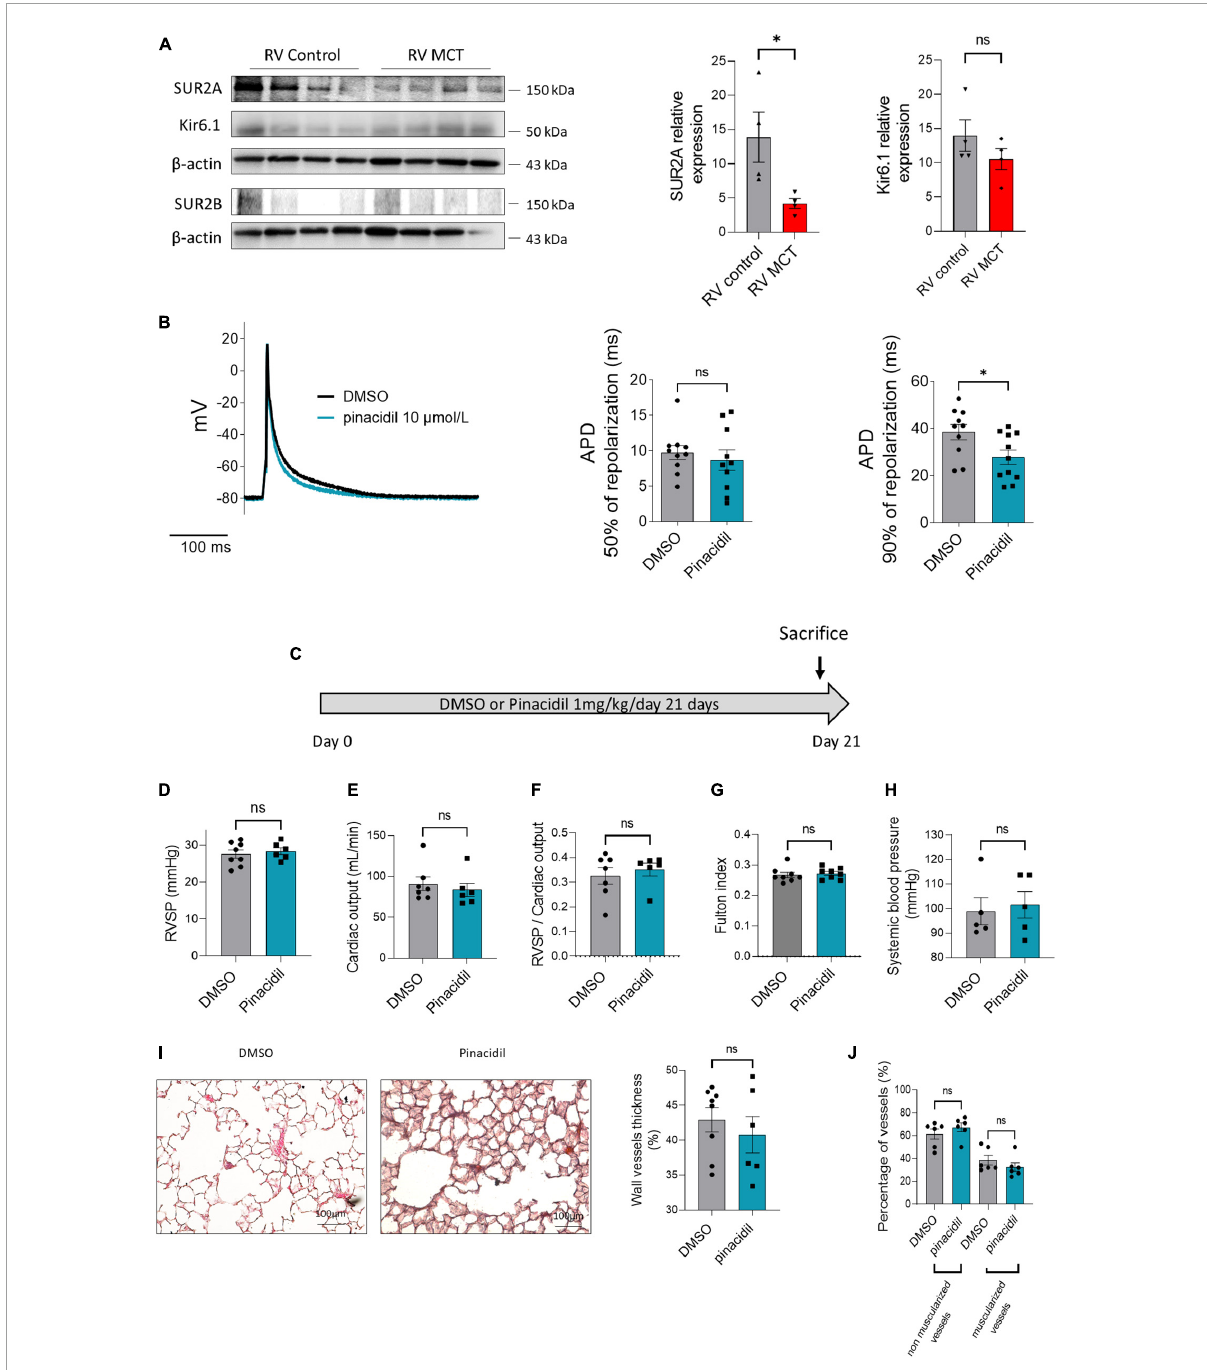
FIGURE5 Consequences of SUR2 pharmacological activation in the RV compartment ( in vitro and in vivo ). (A) Representative Western blots of SUR2A, SUR2B1, and Kir6.1 in RV from control and MCT-PH rats (3 weeks), and quantification of SUR2A, SUR2B, and Kir6.1 expression in RV from control and MCT-PH rats ( n = 5–8). (B) Representative action potential in RV cardiomyocytes isolated from control rats in DMSO or after perfusion of pinacidil. Analysis of action potential duration at 50 and 90% of AP depolarization in basal conditions and the presence of 10 µ mol/L of pinacidil (12–14 cells from four different rats). (C) In vivo experimental design. Pinacidil (1 mg/kg / day for 3 weeks) was administered long-term to healthy control rats by intraperitoneal injection. (D) RVSP (mmHg; n = 6–8 rats per condition). (E) CO (mL/min) ( n = 6–8 rats per condition). (F) PVR ( n = 5 rats per condition) (G) Fulton index ( n = 6–8 rats per condition) (H) and carotid artery mean pressure ( n = X–X rats). (I) Pulmonary vessel occlusion (%) was analyzed by hematoxylin-eosin Safran staining (HES) ( n = 6–8 rats per condition). (J) Percentage of non-muscularised and muscularised vessels [100 vessels per rat, ( n = 6–8 rats)] as measured by immunostaining against α -smooth muscle actin ( α SMA) and Von Willebrand Factor (VWF). ns: non-significant. ∗ p < 0.05